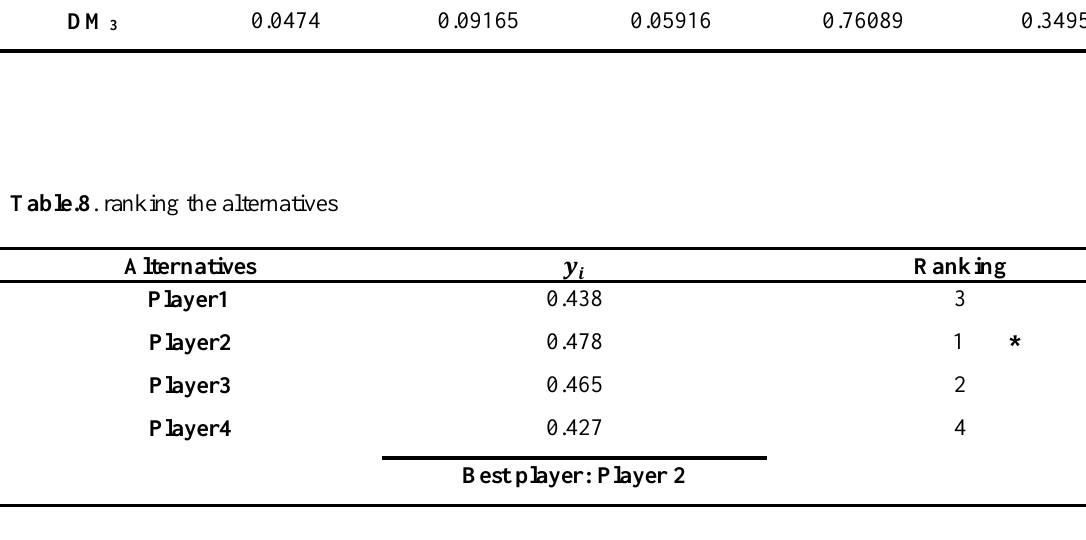
Table.7 . separations, closeness coefficient and weight of each DM DMs 𝑺 𝒌+ 𝑺 𝒌𝒍− 𝑺 𝒌𝒓− 𝑪 DM 1 0.0636 0.05744 0.04358 0.61365 0.2818 DM 2 0.0344 0.08246 0.05744 0.80263 0.3687 DM 3 0.0474 0.09165 0.05916 0.76089 0.3495